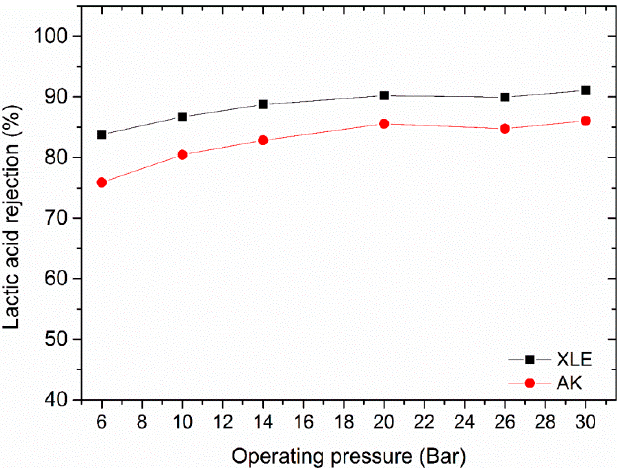
Figure 6. Effect of the absence of KCl on lactic acid rejection. Feed solution 0.9 ± 0.1 g/L of lactic acid, pH of 2.85 and operating temperature of 25 °C.